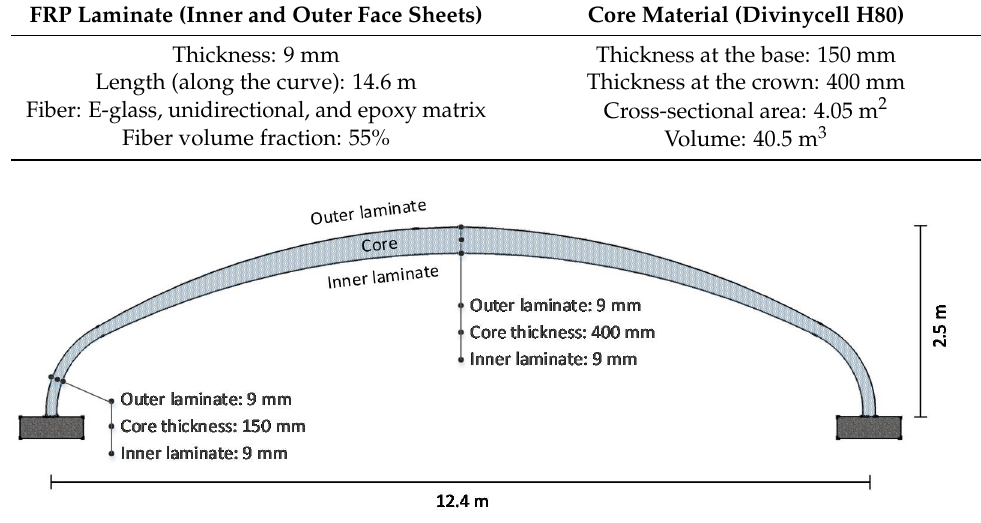
Figure 9. Cross-sectional dimensions of the FRP sandwich shell .